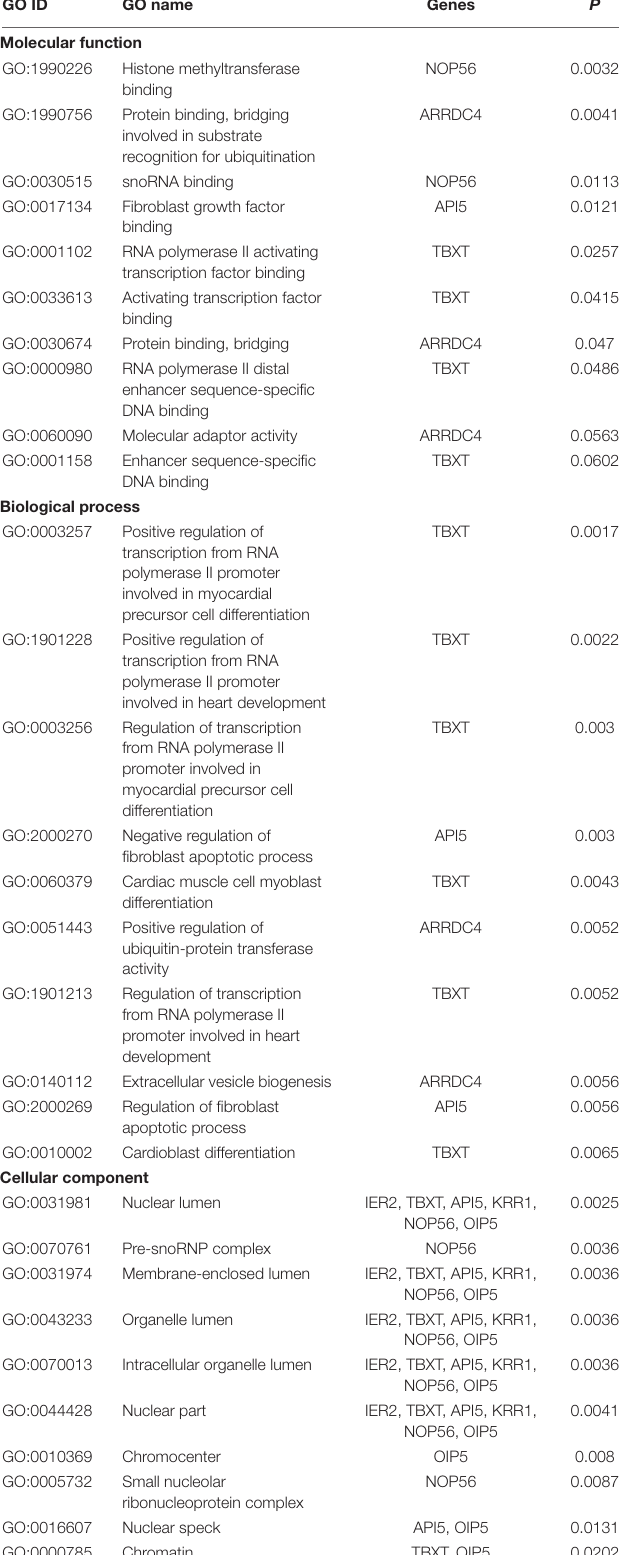
TABLE 5 | Top 10 significantly enriched Kyoto Encyclopedia of Genes and Genomes (KEGG) pathways of target genes of all long non-coding RNAs. KEGG